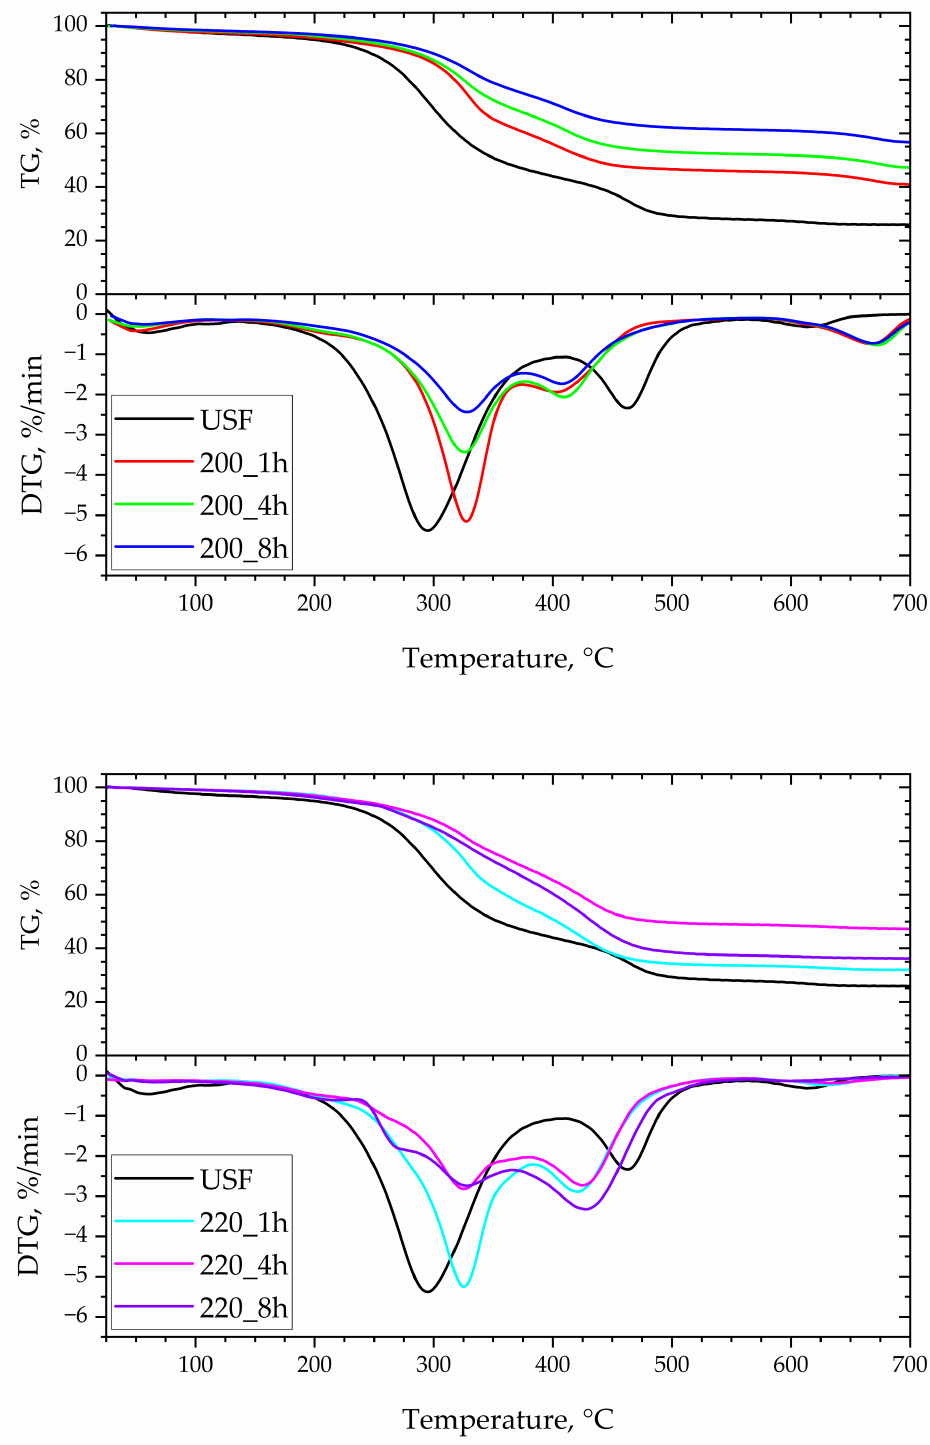
Figure 6. Comparison of TG and DTG curves for samples hydrothermally treated at 200 and 220 ◦